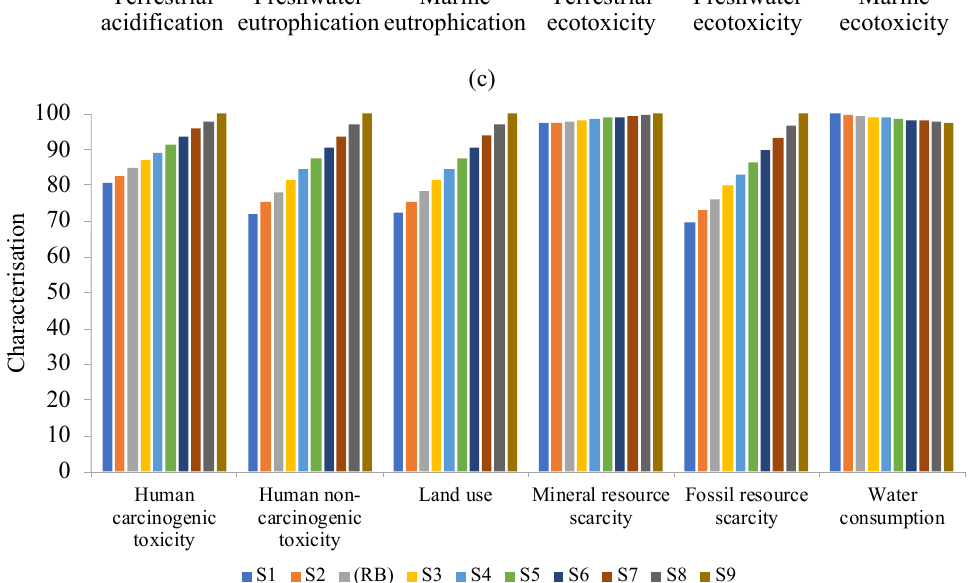
Figure 4. The characterisation results of the 18 impact categories in ReCiPe Midpoint (H) 2016: ( a ) Global warming, Stratospheric ozone depletion, Ionizing radiation, Ozone formation, Human health, Fine particulate matter formation, and Ozone formation; ( b ) Terrestrial ecosystems, Terrestrial acidification, Freshwater eutrophication, Marine eutrophication, Terrestrial ecotoxicity, Freshwater ecotoxicity, and Marine ecotoxicity; ( c ) Human carcinogenic toxicity, Human non- carcinogenic toxicity, Land use, Mineral resource scarcity, Fossil resource scarcity, and Water